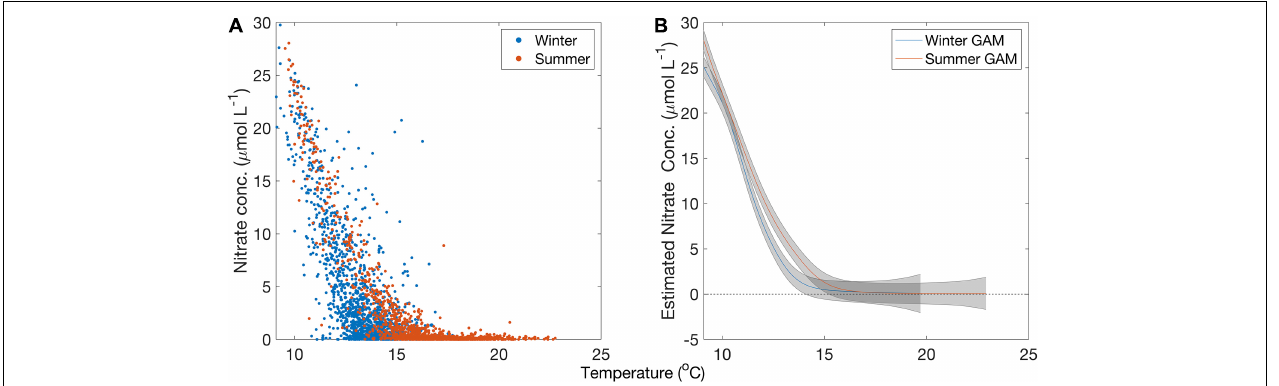
FIGURE 4 | (A) Temperature and nitrate measurements separated by season in the Southern California Bight. Blue markers are datapoints collected during wintertime, red markers are datapoints collected during summertime. (B) Generalized additive model fit for temperature to nitrate relationships in the winter and summer months in the Santa Barbara Channel from 1980 to 2018 above 3 m depth. Blue line is the winter GAM, and red line is the summer GAM. Gray bars are the standard error about the